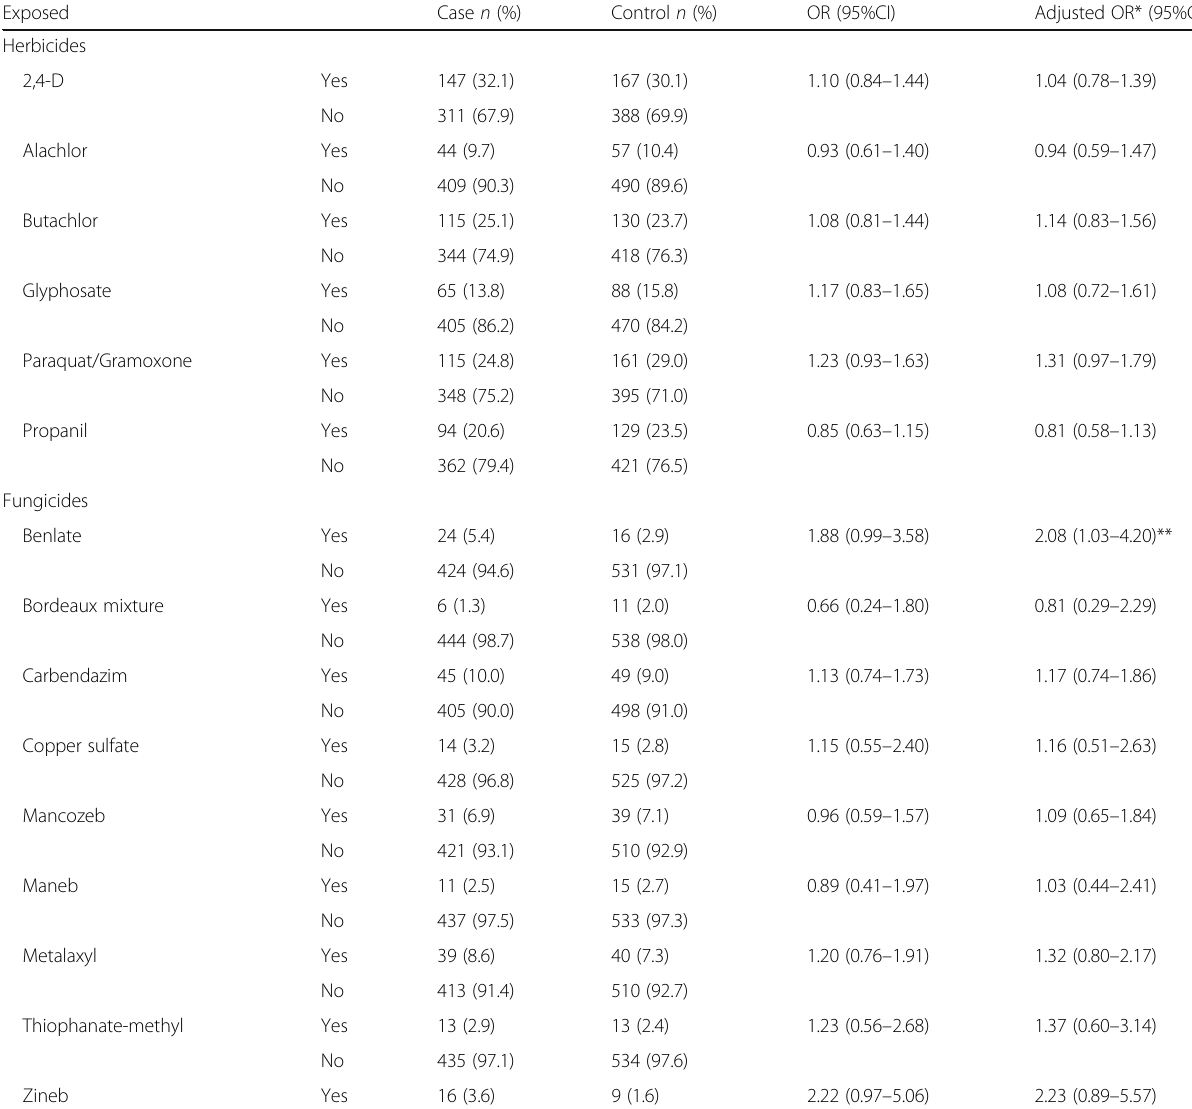
Table 3 Associations between individual pesticide and diabetes (Continued)